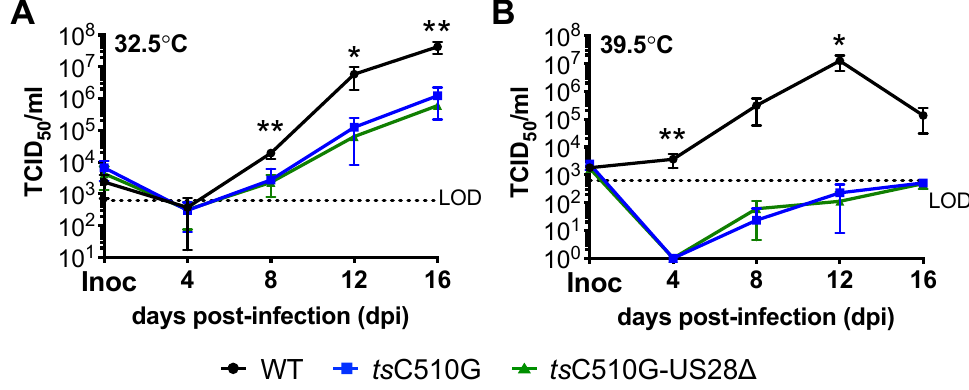
Figure 1. ts C510G-US28∆ replicates to similar titers as ts C510G in lytically infected fibroblasts. NuFF-1 cells were infected (moi = 0.01 TCID 50 /cell) as indicated at the ( A ) permissive (32.5 °C) or ( B ) non-permissive (39.5 °C) temperature. Extracellular virus was collected over a 16 d time course and titered on naïve NuFF-1 cells at the permissive temperature (32.5 °C) by TCID 50 . Error bars indicate standard deviation, and statistical significance was calculated using one-way ANOVA with Tukey’s multiple comparison test: ( A ) * p < 0.05 (WT vs. ts C510G; WT vs. ts C510G-US28∆); ** p < 0.01 (WT vs. ts C510G; WT vs. ts C510G-US28∆); all other comparisons were not significant. ( B ) * p = 0.0203 (WT vs. ts C510G; WT vs. ts C510G-US28∆); ** p = 0.0169 (WT vs. ts C510G; WT vs. ts C510G-US28∆); day 8: p = 0.0869 (for each, WT vs. ts C510G; WT vs. ts C510G-US28∆); day 16: p = 0.0765 (WT vs. ts C510G) and p = 0.0764 (WT vs. ts C510G-US28∆). LOD, level of detection. n = 3; representative experiment is shown, with 3 technical replicates per time point.